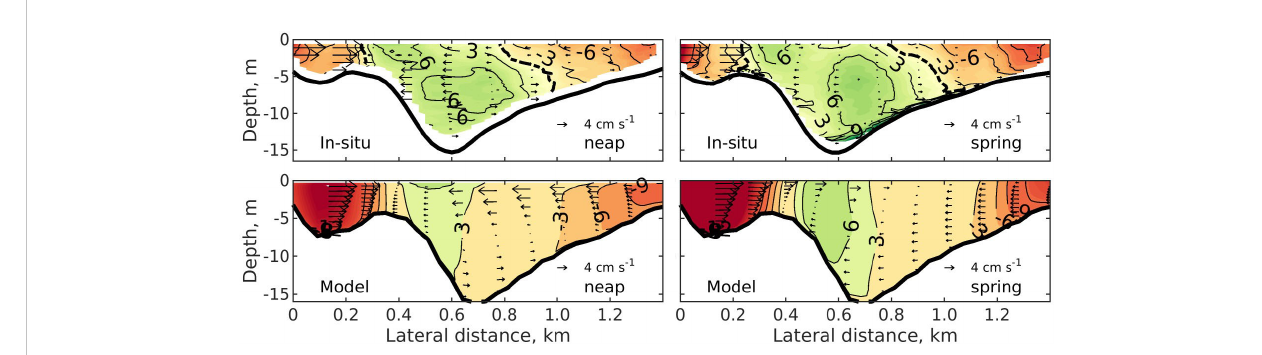
FIGURE 2 (In-situ) measured and (model) simulated residual currents at neap and spring tides along the observed transect. Here, in-situ measurements are adapted from Figure 7 of Valle-Levinson et al. (2018). Contours denote longitudinal currents that are perpendicular to the transect and arrows represent the lateral currents. In the longitudinal direction, positive values (in green contours) indicate in fl ow (when looking seaward). Units of the currents are cm s − 1 . Dashed lines illustrate the 0 cm s − 1 longitudinal current